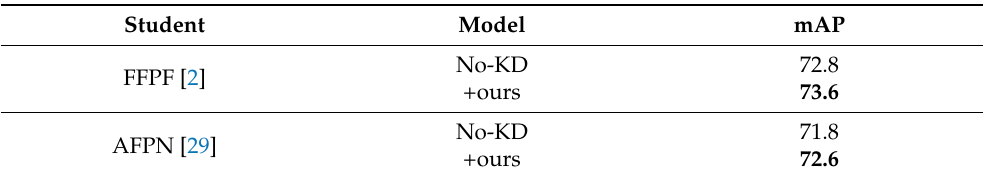
Table 4. Results of more detectors with stronger students and teacher detectors on the DIOR dataset. The best results are marked by bold text.